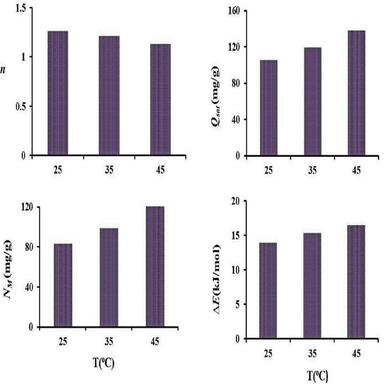
The behavior of steric parameters at different temperatures for the phenol adsorption on nZVI@Ach adsorbent.